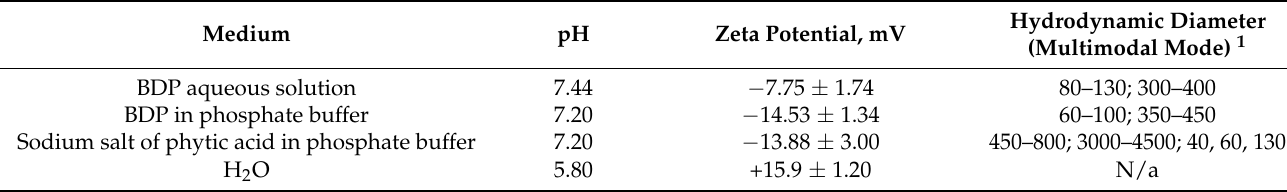
Table 8. Data of zeta potential and hydrodynamic diameter of ZnO NPs dispersions (20 mg/10 mL) in solutions of 2.66 ∙ 10 − 2 M BDP.